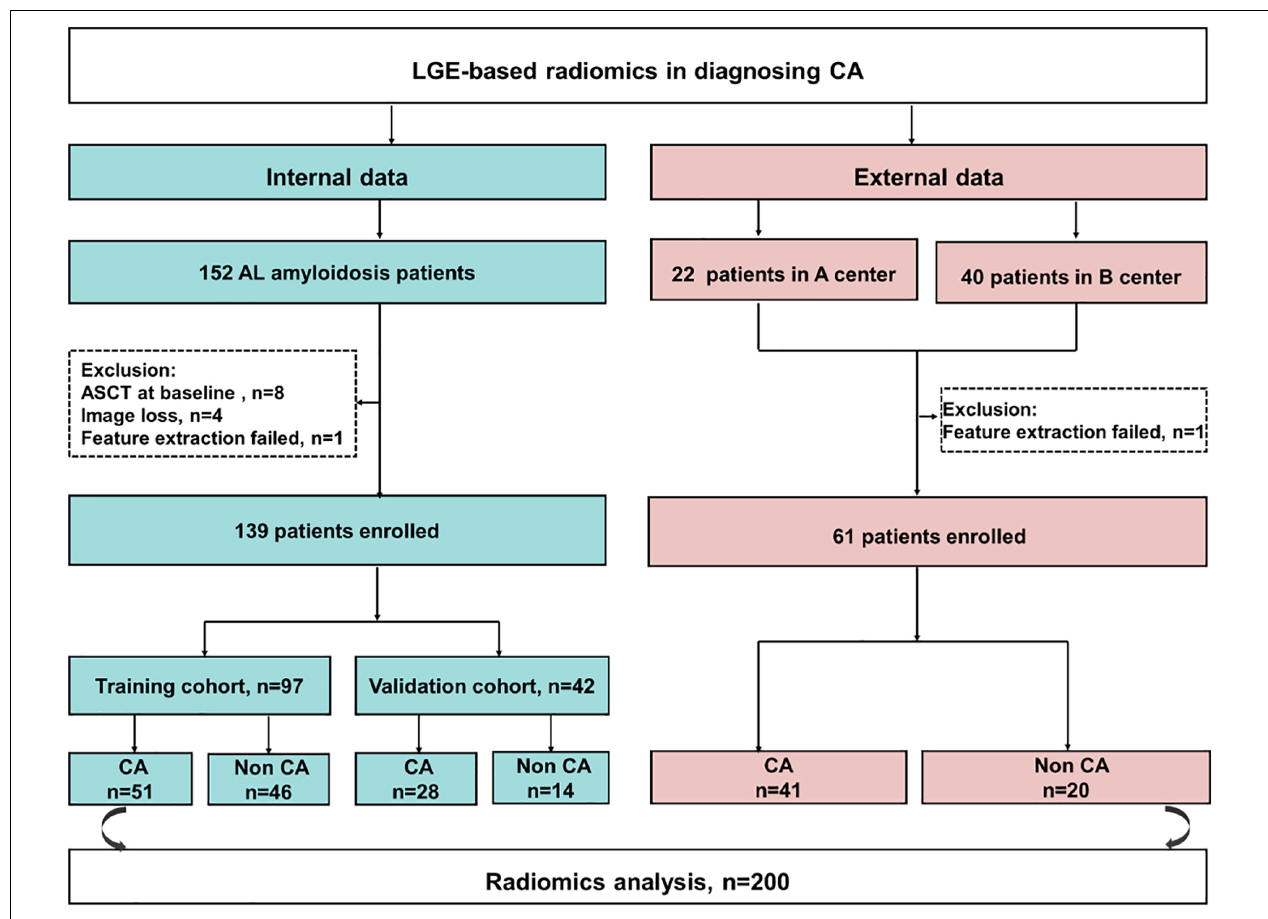
FIGURE 1 | The flowchart of this study. CA, cardiac amyloidosis; AL, light chain amyloidosis; ASCT, autologous stem cell transplant; A center, the Second West China Hospital, Sichuan University, China; B center, Peking Union Medical College Hospital,